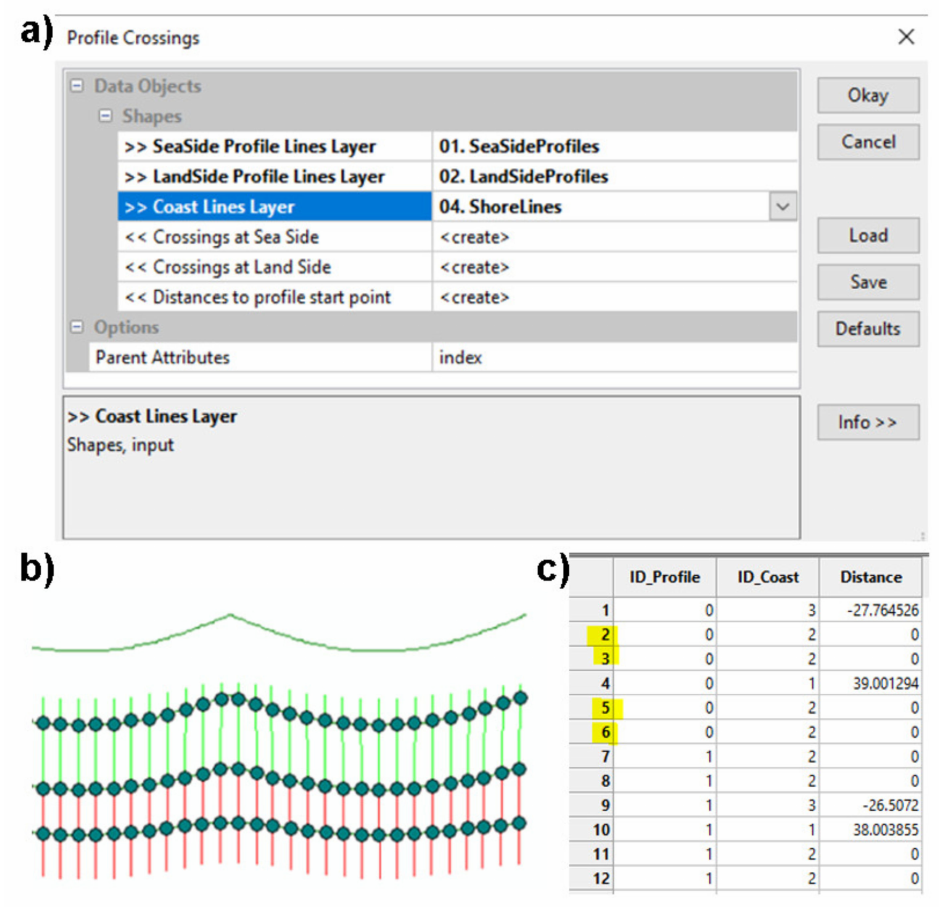
Figure 6. The ProfileCrossings tool. ( a ) Window with the mandatory inputs to the ProfileCrossings process; ( b ) example of shorelines with the normal lines and the intersection points; and ( c ) detail of point-intersection output and the duplicated points highlighted (notice that distance is 0 for all duplicates, as this point coincides with the transect starting point and is crossed twice by the landward and seaward